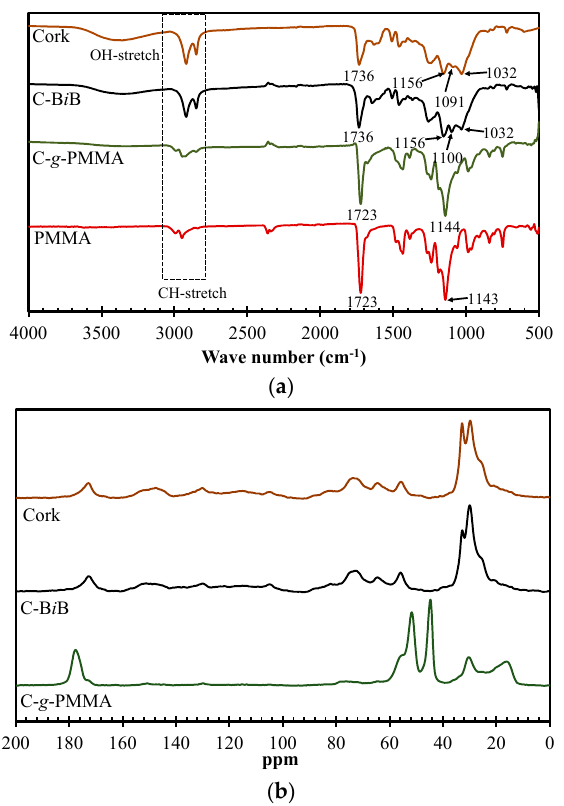
Figure 1. ATR-FTIR ( a ) and 13 C CP/MAS solid state NMR ( b ) of Cork, C-B i B, C- g -PMMA and ATR-FTIR of homopolymer PMMA (produced via ATRP).